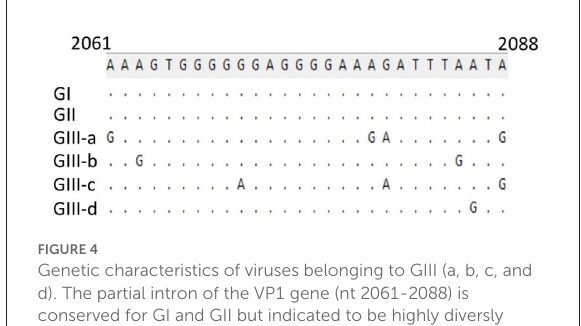
FIGURE4 Genetic characteristics of viruses belonging to GIII (a, b, c, and d). The partial intron of the VP1 gene (nt 2061-2088) is conserved for GI and GII but indicated to be highly diversly variable for GIII-a, b, c, and d. Numbers indicate the nucleotide position relative to the genome of virus strain CPV6, GenBank ID: